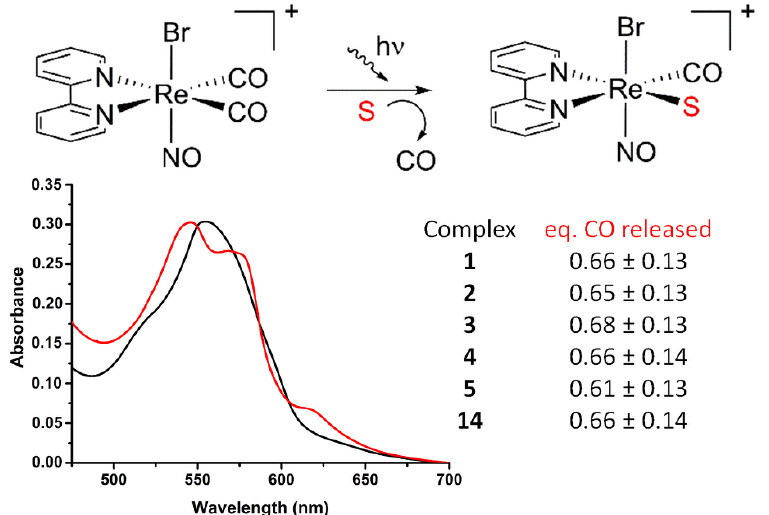
Figure 9. Typical UV-visible spectrum of conversion of deoxy-myoglobin (deoxy-Mb) to carbon monoxide myoglobin (MbCO) by fac -[Re I (CO) 2 (NO)(N-N)Br]BF 4 complexes 1 – 5 and 14 . Solutions (20 μ M Mb and photoCORM, 25 °C, 0.05 M phosphate buffer at pH 6.8) were exposed to a 275 nm light source (intervals of 10 min) before the conversion reached a plateau after 120 min. Prolonged exposure to the light source eventually favoured formation of metmyoglobin (MetMb), as evidenced by the peak at 620 nm. In the reaction scheme above the spectra, S = solvent molecule.